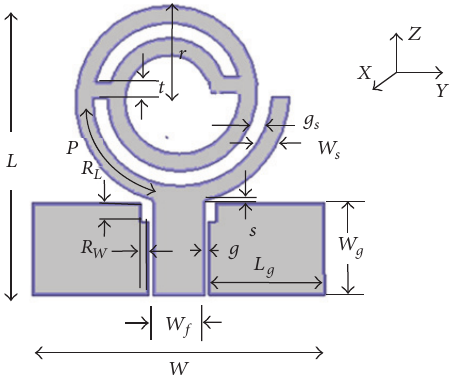
Figure 1: Geometry of the proposed